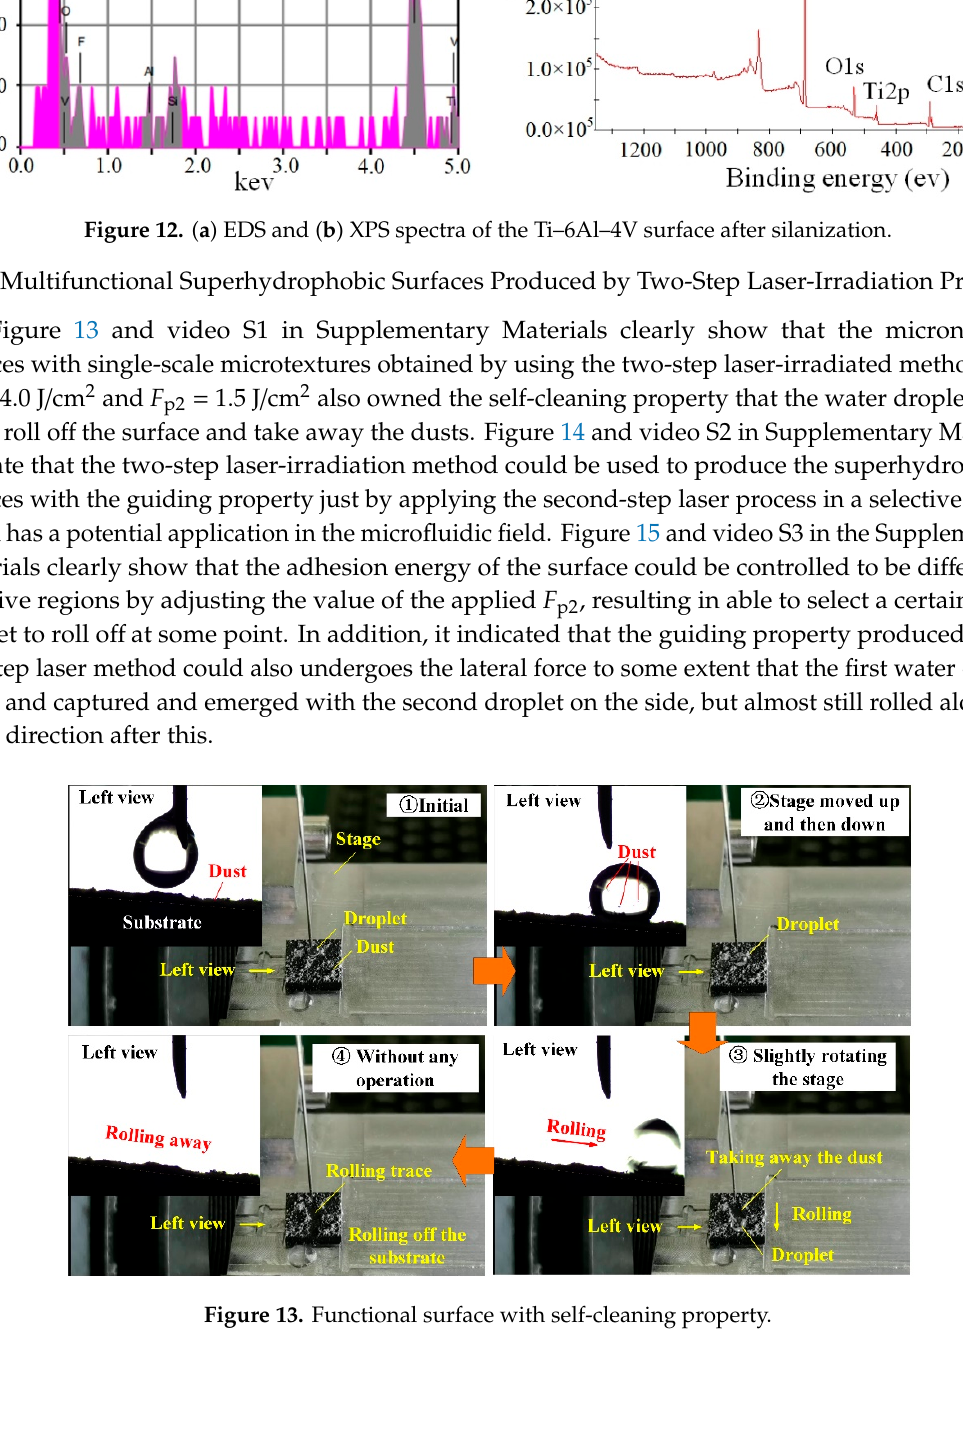
Figure 14. Functional surface with guiding property produced by using F p1 = 5.2 J/cm 2 and F p2 = 2.9 J/cm 2 .